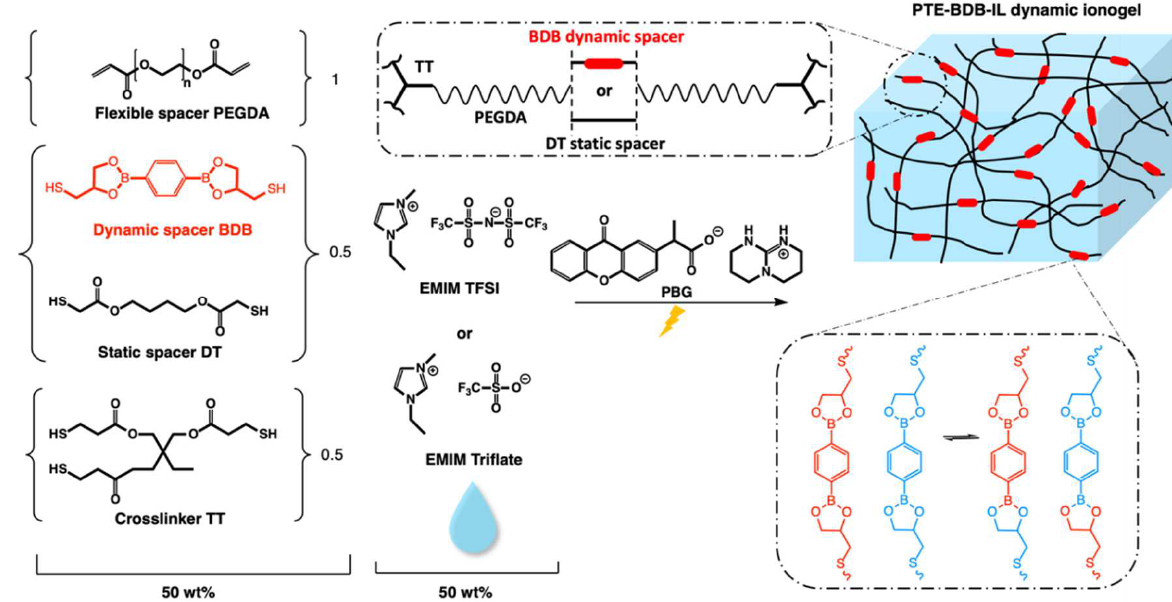
Figure 1. Chemical composition and illustration of the PTE-BDB-IL dynamic ionogels based on boronic ester exchange reaction. We used a 1:1 stoichiometric ratio of acrylate and thiols (1.0 diacrylate: 0.5 dithiol: 0.5 trithiol). Samples were prepared in different proportions between the flexible spacer DT and the boronic ester dynamic spacer BDB, which is capable of a fast bond exchange reaction. Fifty wt% of either EMIM TFSI or EMIM Triflate compared to the total weight is used to prepare PTE-BDB-IL dynamic ionogels.